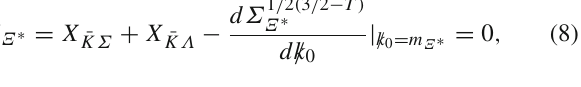
constant of the hadron wave function is set to zero,